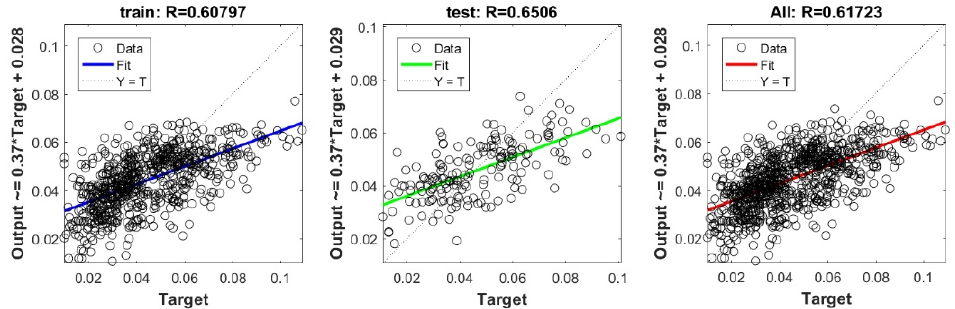
Figure A13. Scatter plots between target and output value by the GT-GP model.